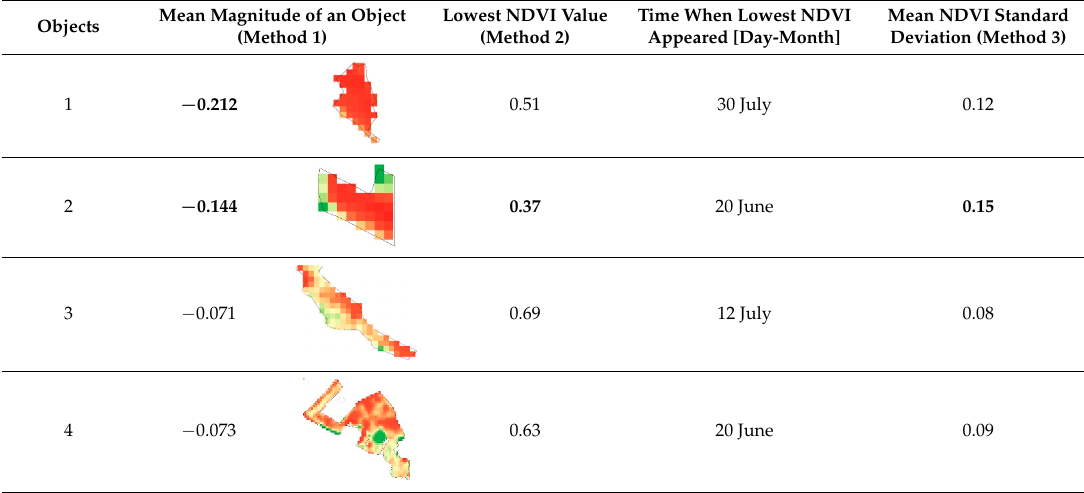
Table 2. Cross-comparison of the methods used in this study and their main statistics. Values that have the highest deviation are highlighted for each